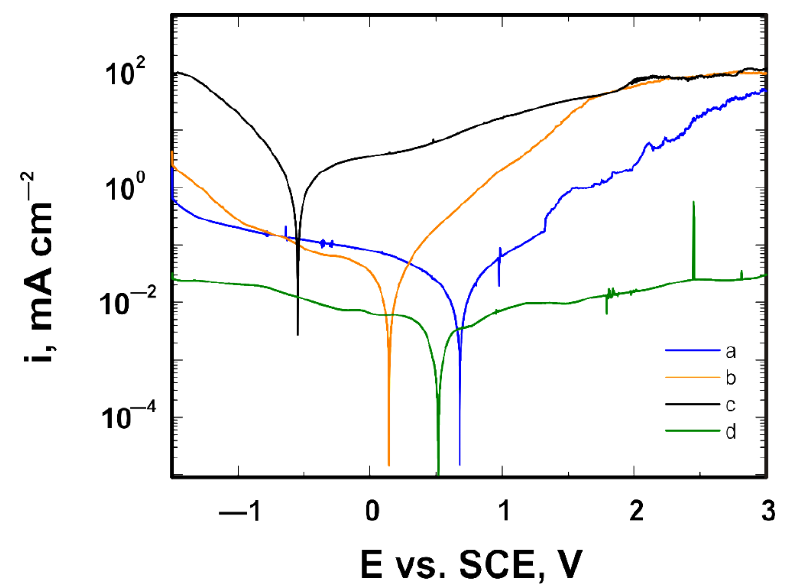
Figure 9. Potentiodynamic polarization curves analyzed in ( a ) artificial saliva solution, ( b ) simulated body fluid, ( c ) Hank’s solution and ( d ) Ringer’s solution , for Ti Gr 2 coated with the VTMS coating.